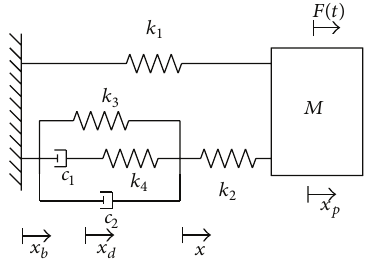
Figure 2: Complicated model.